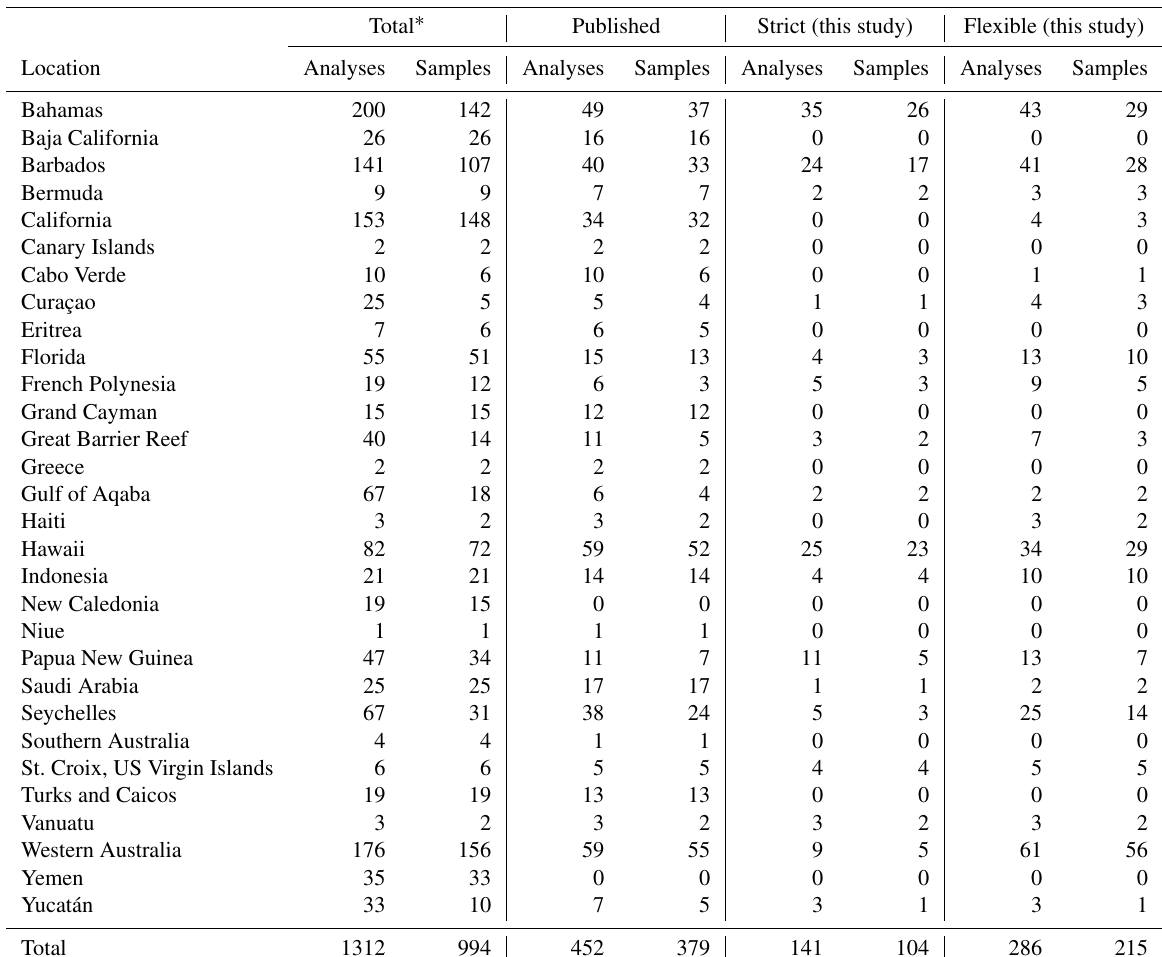
Table 1. Summary of samples that passed closed-system screening